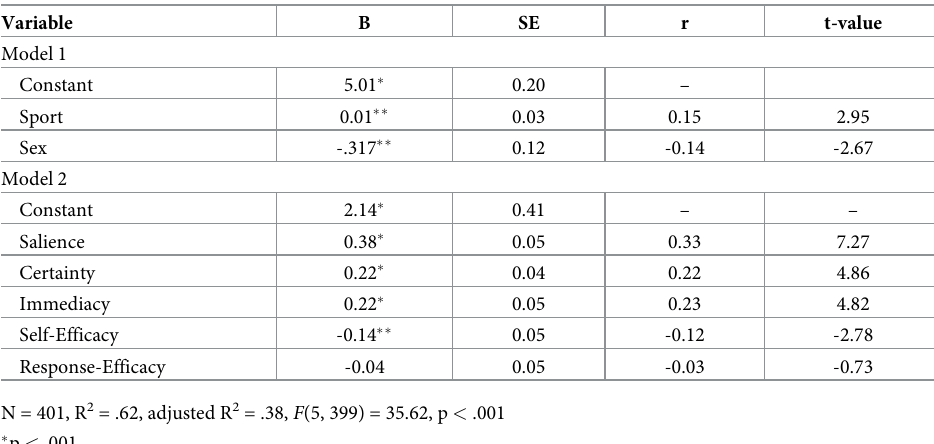
Table 4. Regression analysis for perceptions of